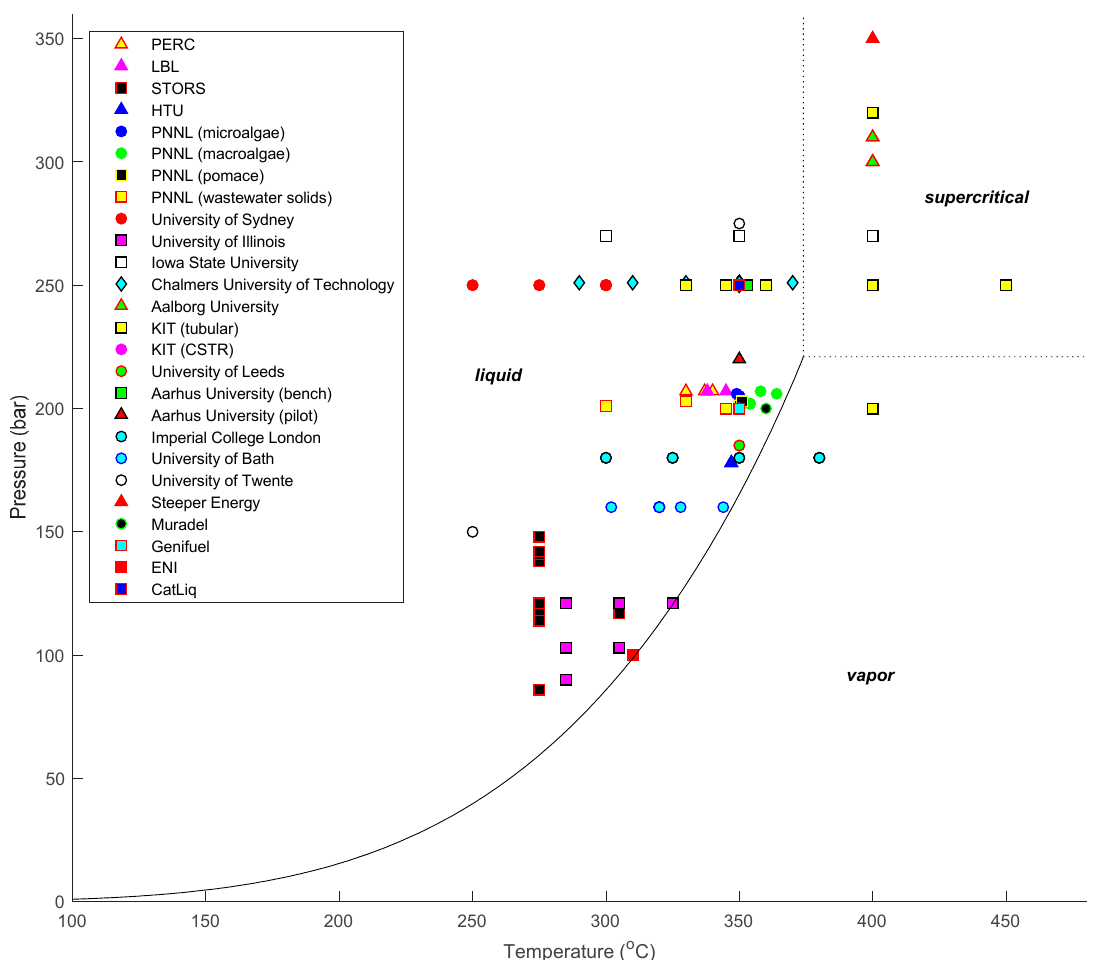
Figure 2. State diagram of water reporting temperature and pressure of the continuous HTL reported in the literature.